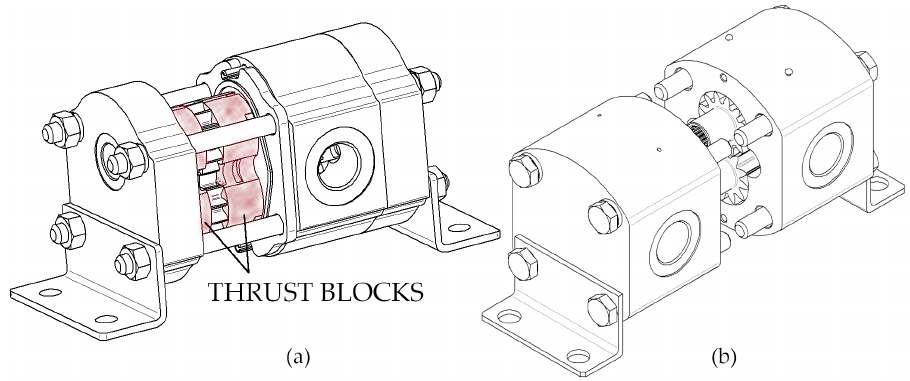
Figure 4. TB divider ( a ) and NTB divider ( b